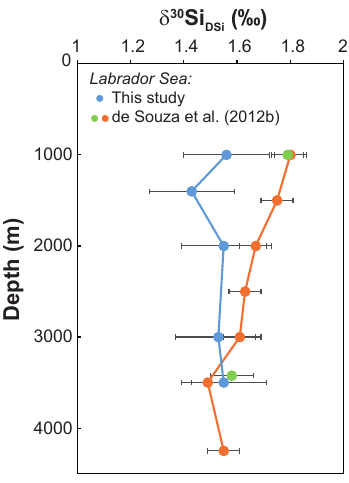
Figure 6. Data from the Labrador Sea (STN 69; blue) during the GEOVIDE cruise (2014) compared with data from samples col- lected in 2010 from nearby stations in the Labrador Sea (green) and at the Grand Banks (orange) (stations 8 and 11 in de Souza et al.